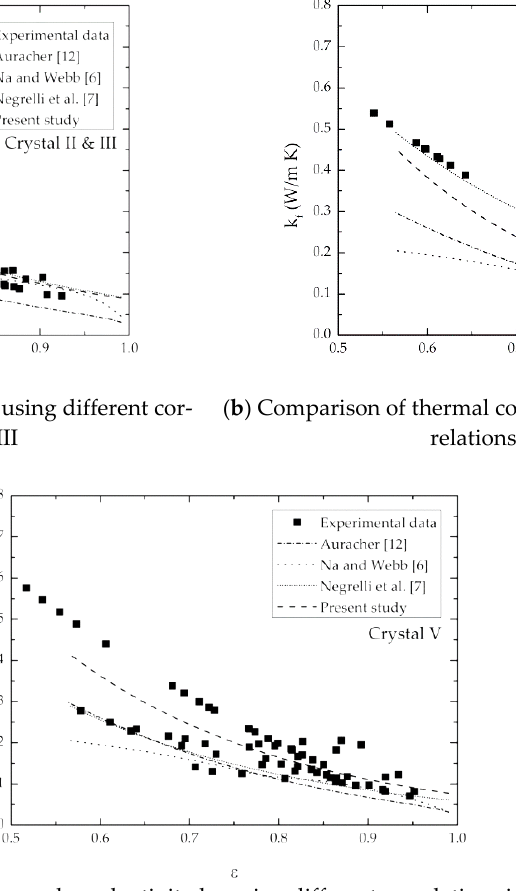
Figure 6. Comparison of thermal conductivity subject to different crystal geometry.